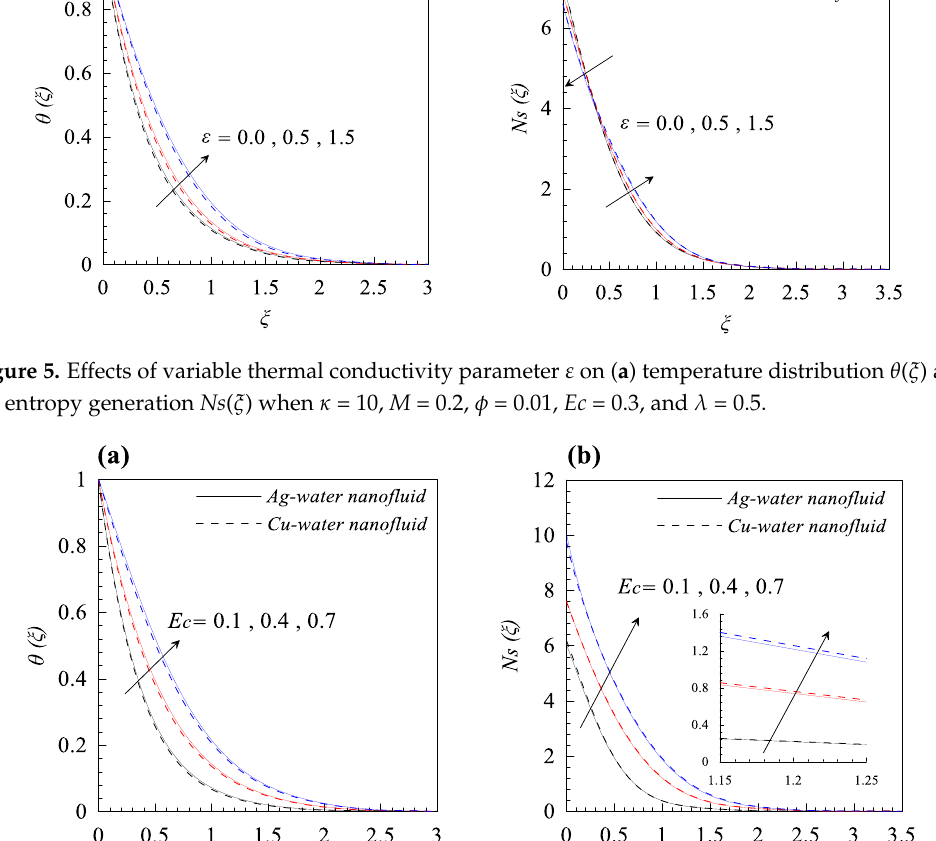
Figure 6. Effects of Eckert number Ec on ( a ) temperature distribution θ ( ξ ) and ( b ) entropy generation Ns ( ξ ), when κ = 10, M = 0.2, φ = 0.01, ε = 0.2, and λ =